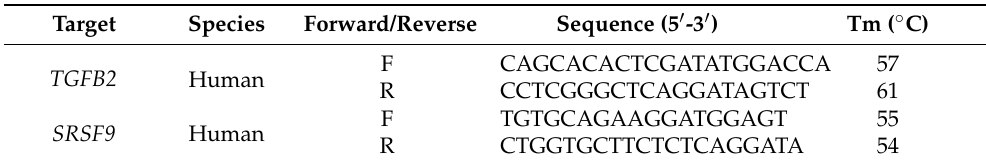
Table 1. Primer sequences of target genes used for